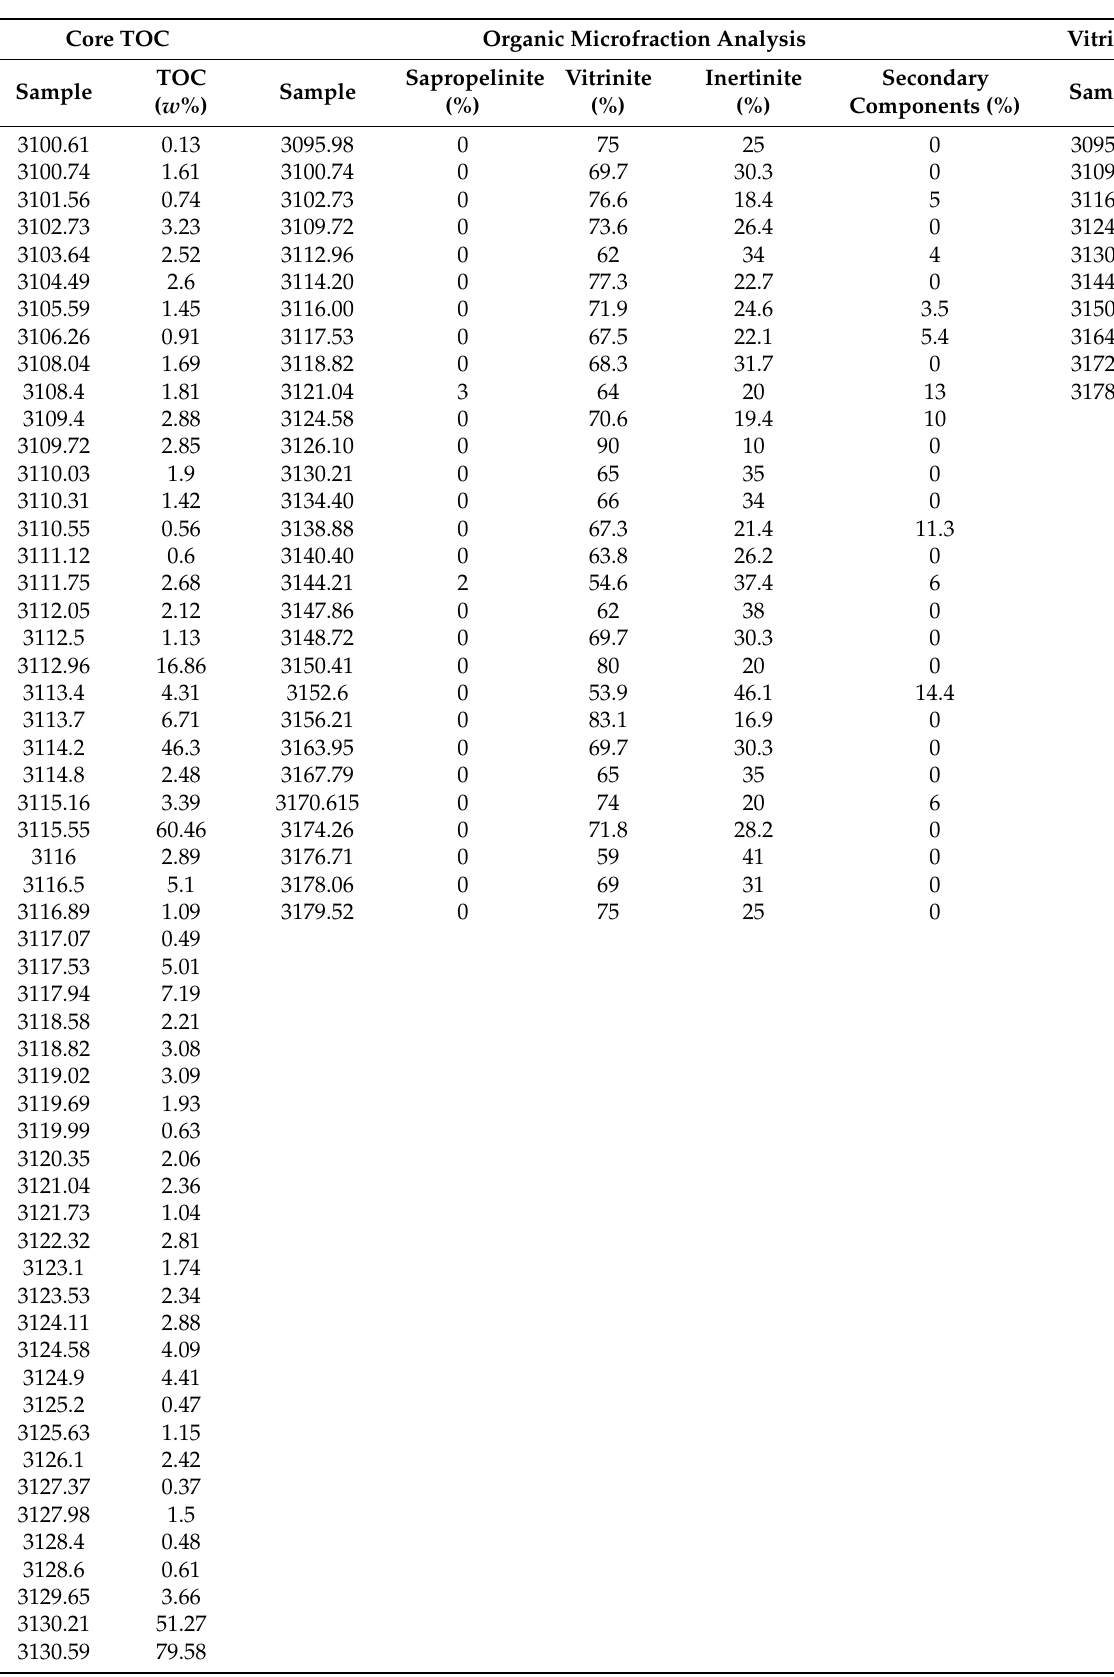
Table 3. Core experimental data of well